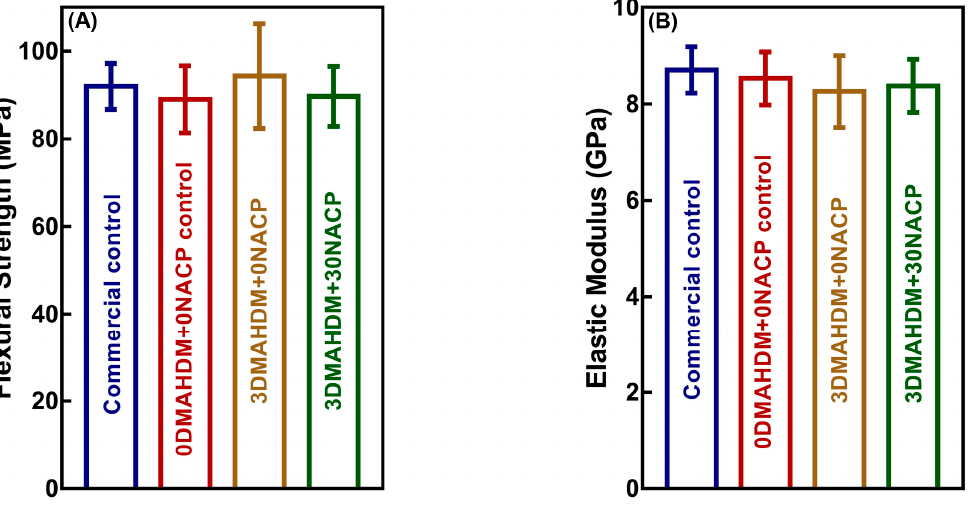
Figure 1. Mechanical properties of composites. ( A ) Flexural strength, and ( B ) elastic modulus (mean ± SD; n = 6). There was no significant difference among the four groups ( p > 0.05).